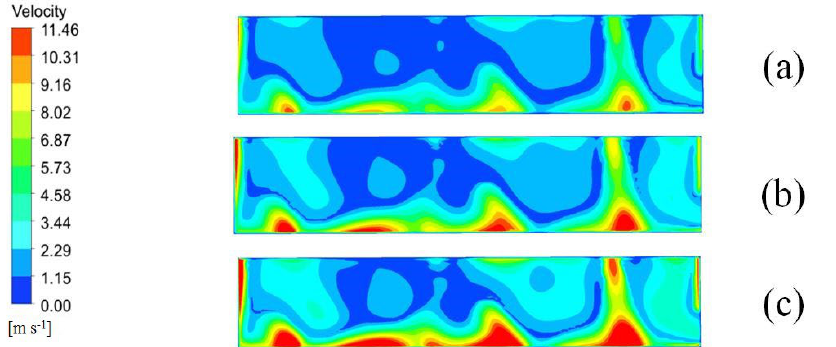
Figure 19. Velocity cloud diagram at the outlet with different WB installed. ( a ) E = 0; ( b ) E = 20; ( c ) E = 40.